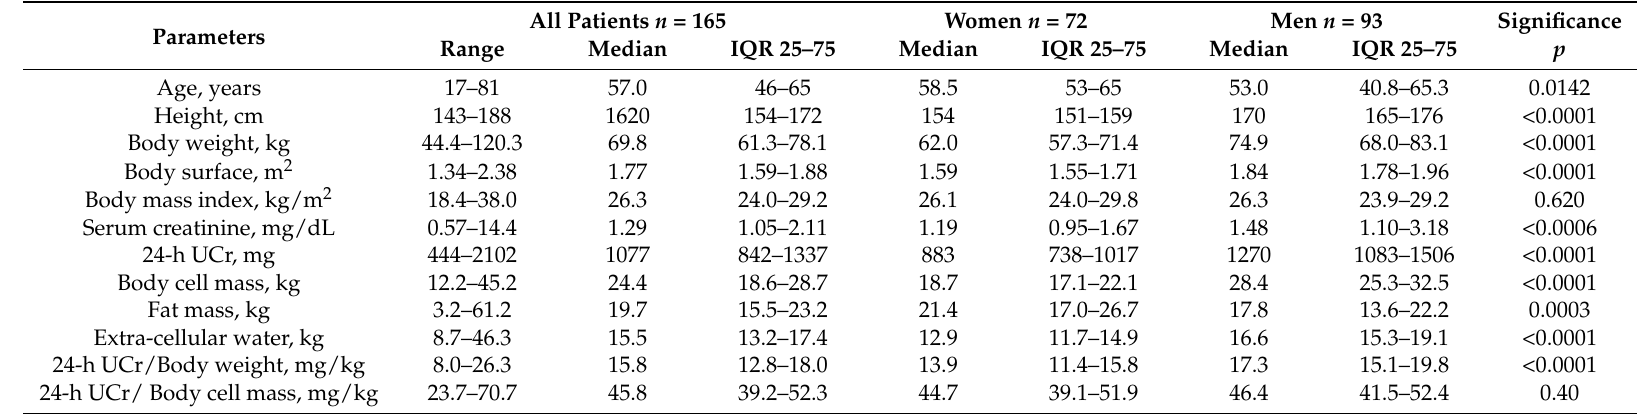
Table 1. Main anthropometric, clinical, and laboratory data of the 165 patients. Median values and interquartile ranges (IQR 25–75) are reported. The statistical significance of the differences between women and men is